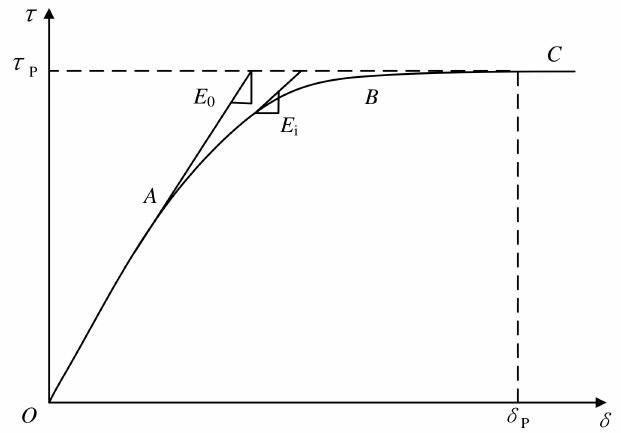
Figure 1. Strain-hardening τ - δ curve.